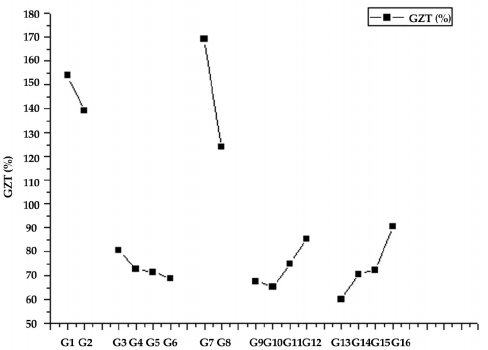
Figure 3. Change trend chart of factor and level for the effect of GZT